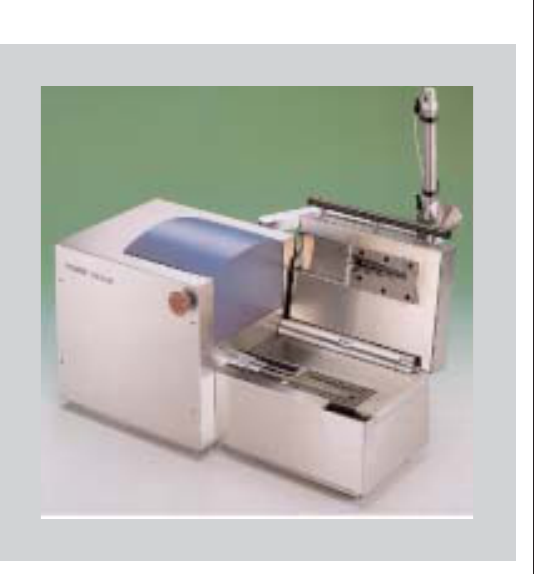
Figure 1: MiniLab.